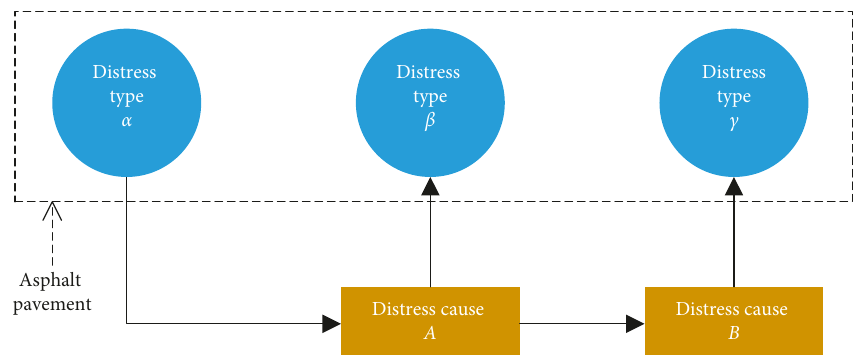
Figure 1: Relationships among different distress types.